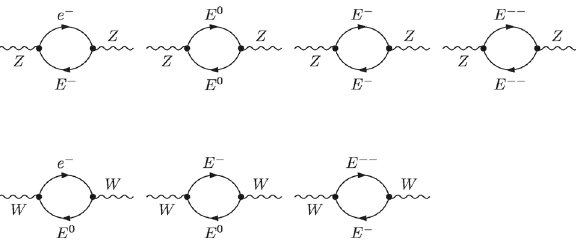
Fig. 1 W and Z boson self energy Feynman diagrams containing excited lepton in the